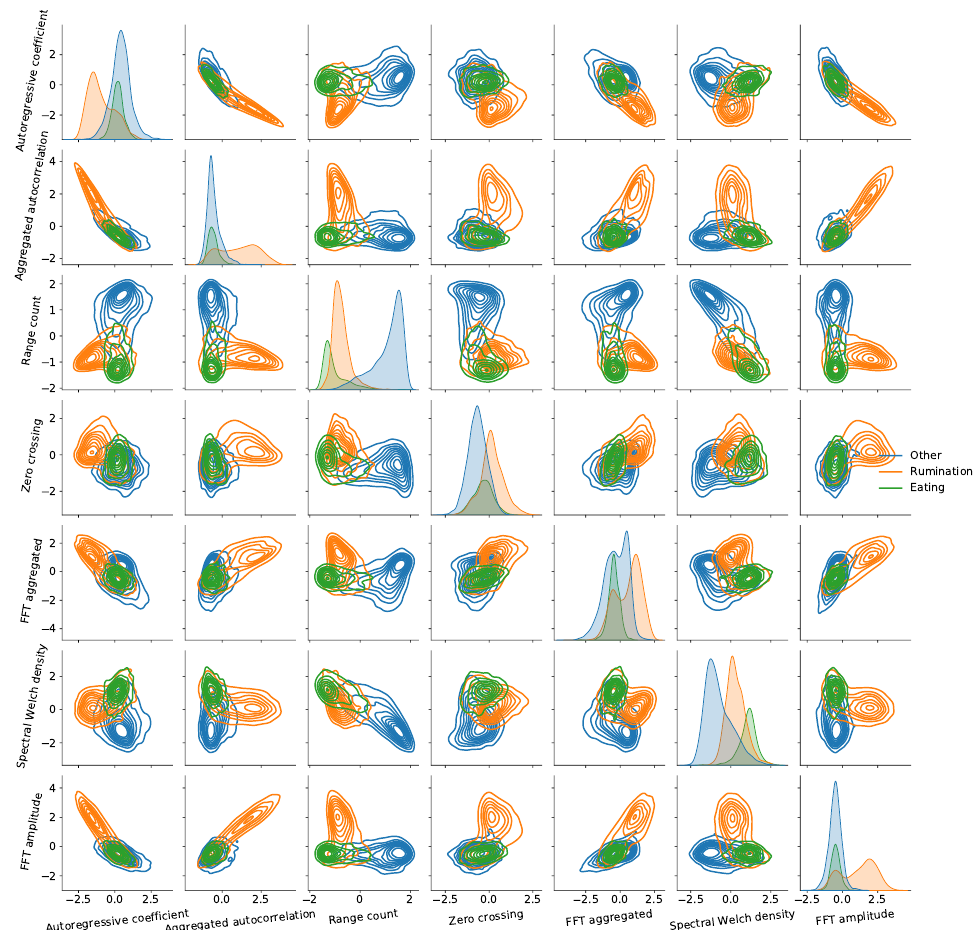
Figure 7. Joint distribution of feature pairs selected by BFE-LDA ‘ (cid:5) ’ with class annotations provided by the truthing data. Note that the diagonal plots are the univariate distributions of each